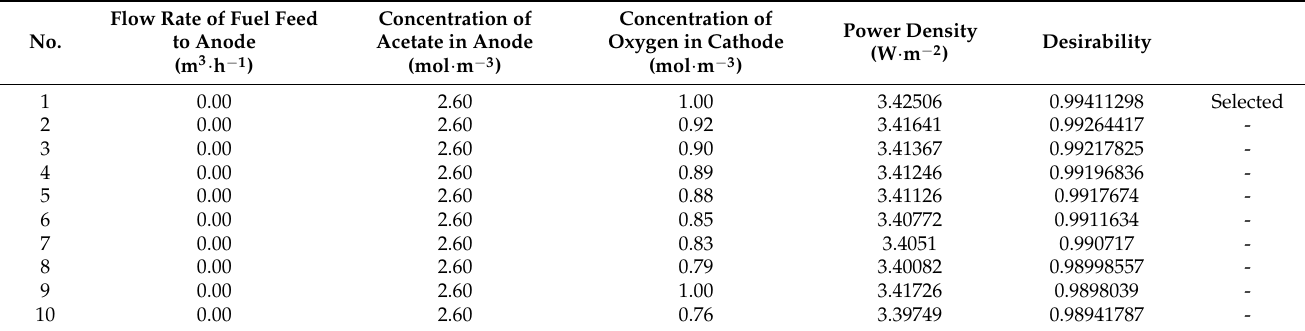
Table 1. Consolidated results of the optimization